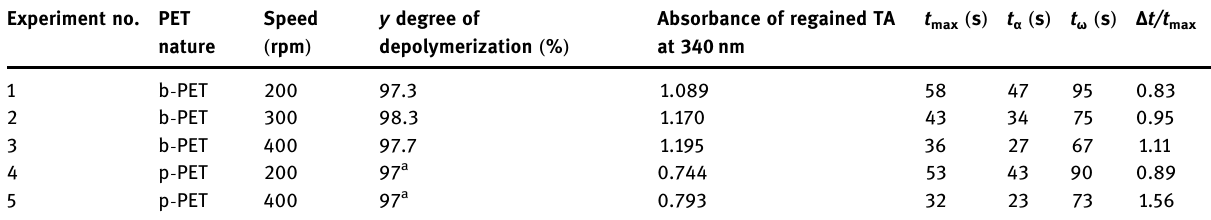
Table 1: Experimental conditions and results Experiment no.